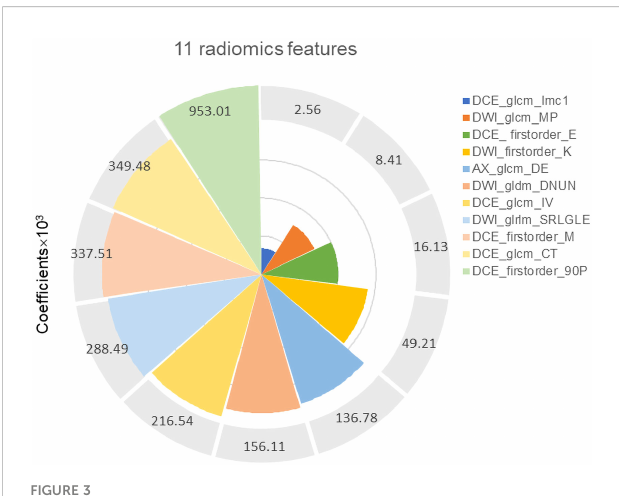
FIGURE 3 Eleven robust radiomics features and corresponding coef fi cients for rad-score construction.